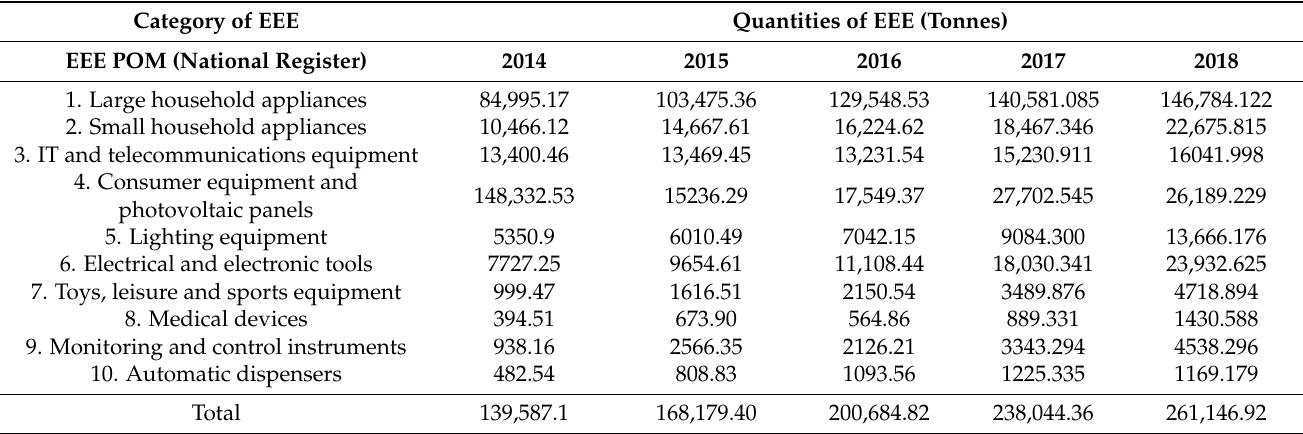
Table 1. Electronic devices placed on the market (EEE-POM) in Romania during 2014–2018, according to the National Agency for Environmental Protection [21].